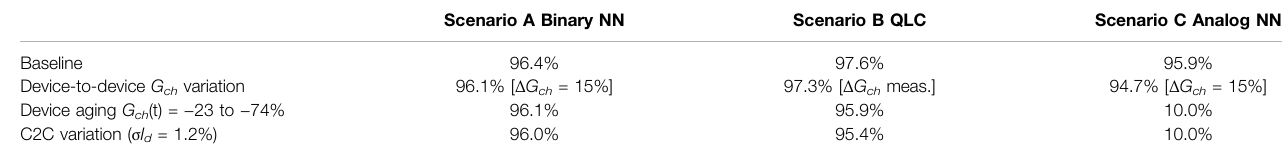
TABLE 2 | Cumulative impact of variations on inference accuracy.